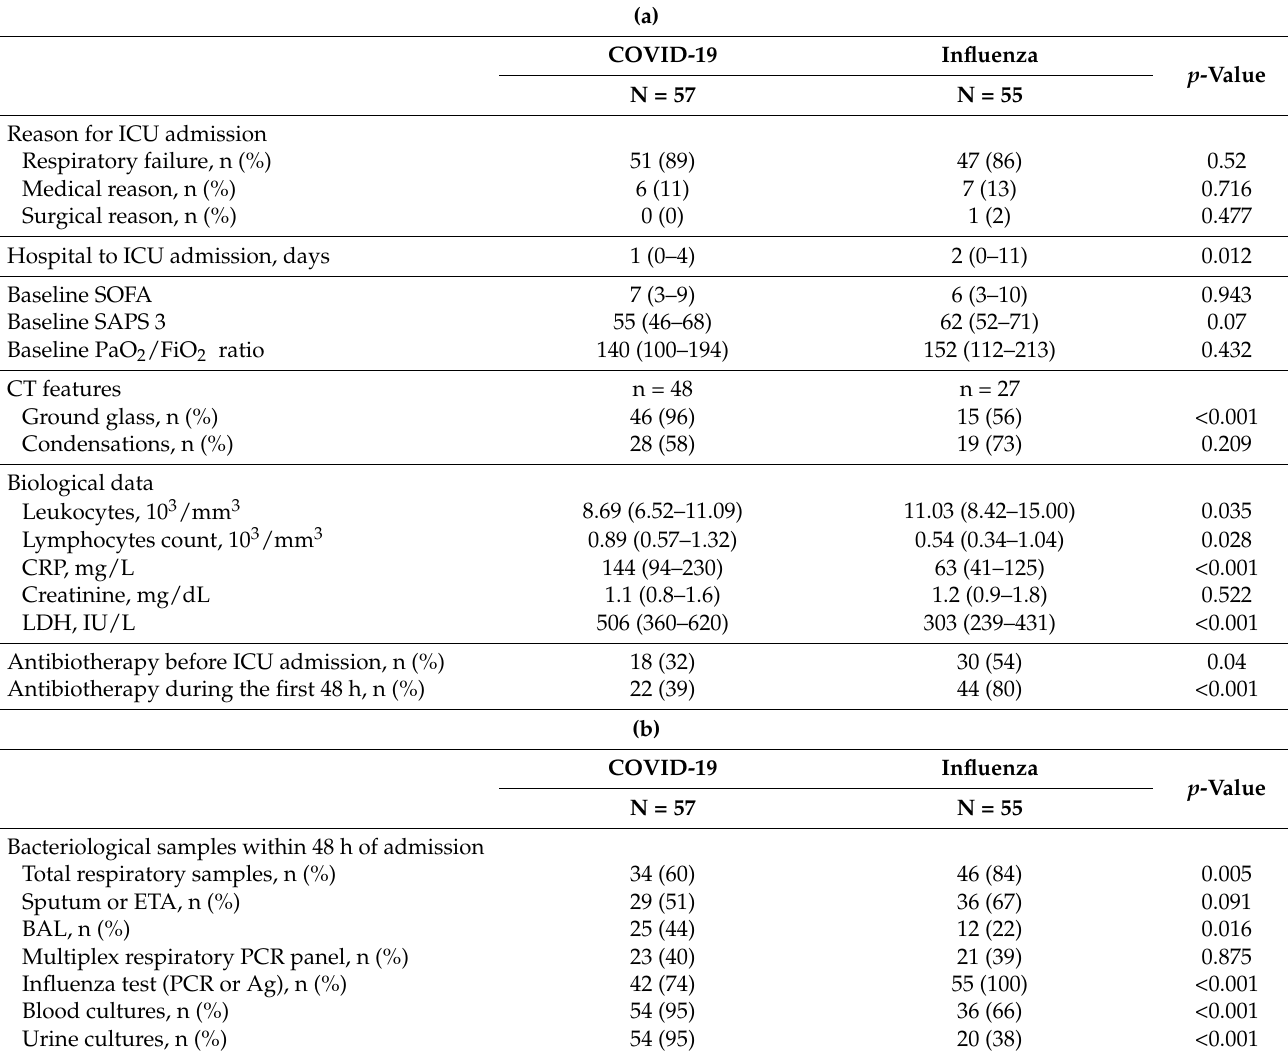
Table 2. (a). Clinical data upon ICU admission. (b). Microbiological data upon ICU